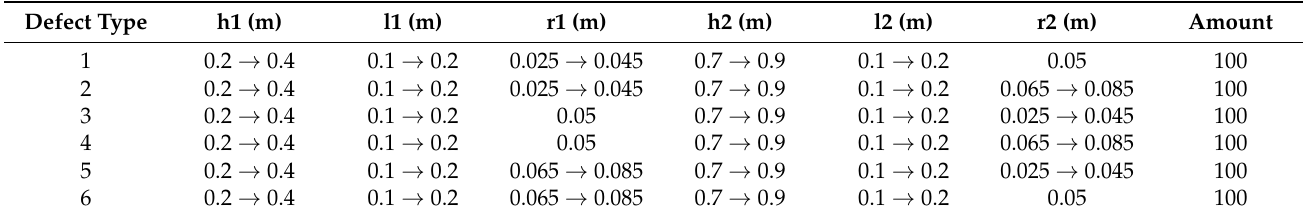
Table 2. Defect conditions of model pile.